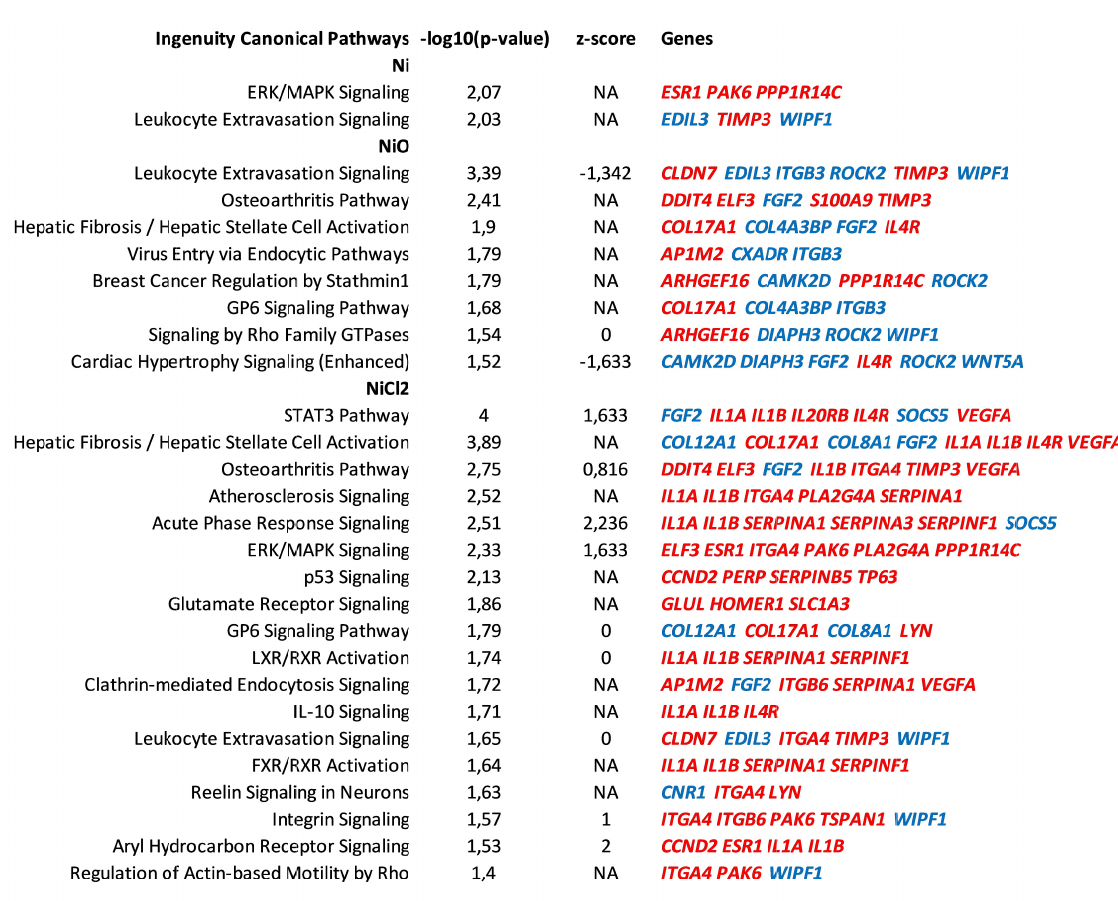
Figure 5. Canonicalpathways enrichedaftersix-weekexposureof BEAS-2Bcellsto Ni, NiOnanoparticles or NiCl 2 . Pathway analysis was performed in IPA on the differentially expressed genes following exposure of BEAS-2B cells to Ni, NiO nanoparticles or NiCl 2 . Significantly enriched canonical pathways ( − log10 ( p -value) > 1.3) are illustrated, ordered according to the statistical significance. Pathways containing less than three differentially expressed genes were excluded. Some pathways are additionally characterized by z-score, a measure of the activation state of the pathway. NA, z-score not available; color coding indicates direction of differential expression, red—upregulation,